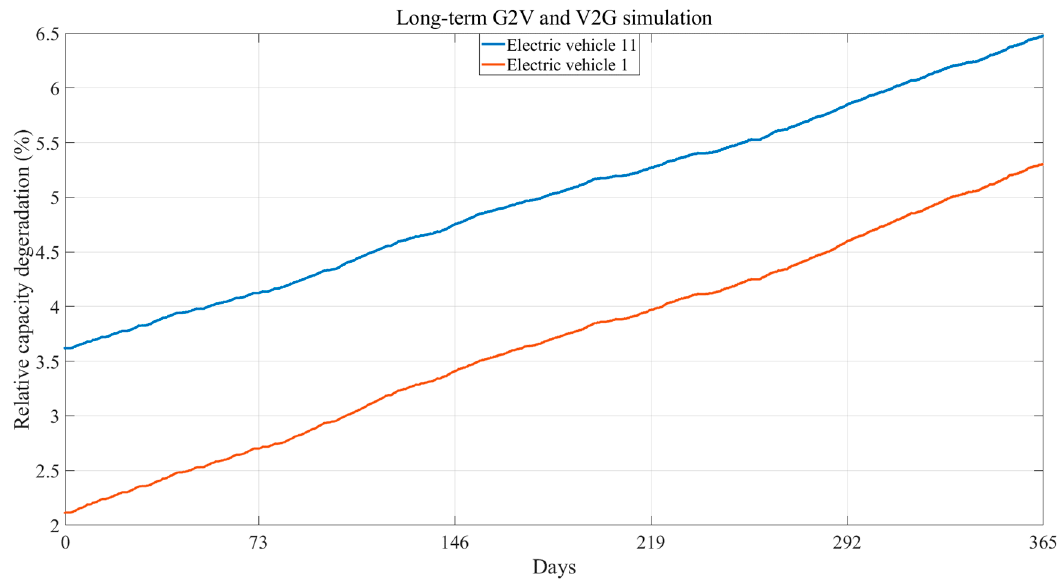
Figure 17. Long-term G2V and V2G simulation for EV1 and EV11.